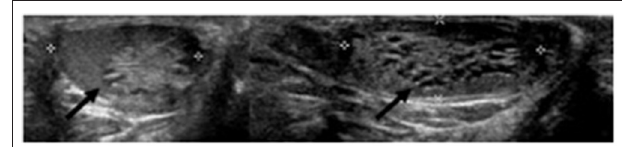
FIGURE 1 | Pre-operative ultrasound of present case. Cysts in the right mediastinum testis (black arrow).